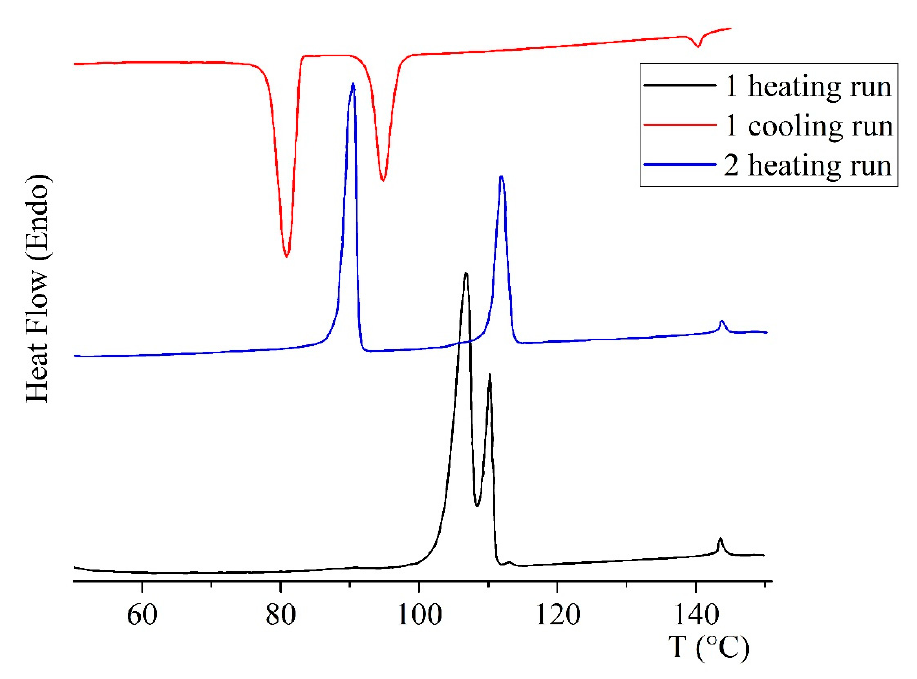
Figure 5 . DSC thermograms of A11O − 6ONPd: (black) first heating; (red) first cooling run; and (blue) Figure 5. DSC thermograms of A11O-6ONPd: (black) first heating; (red) first cooling run; and (blue) second heating run at 10 K/min scanning rate. second heating run at 10 K/min scanning